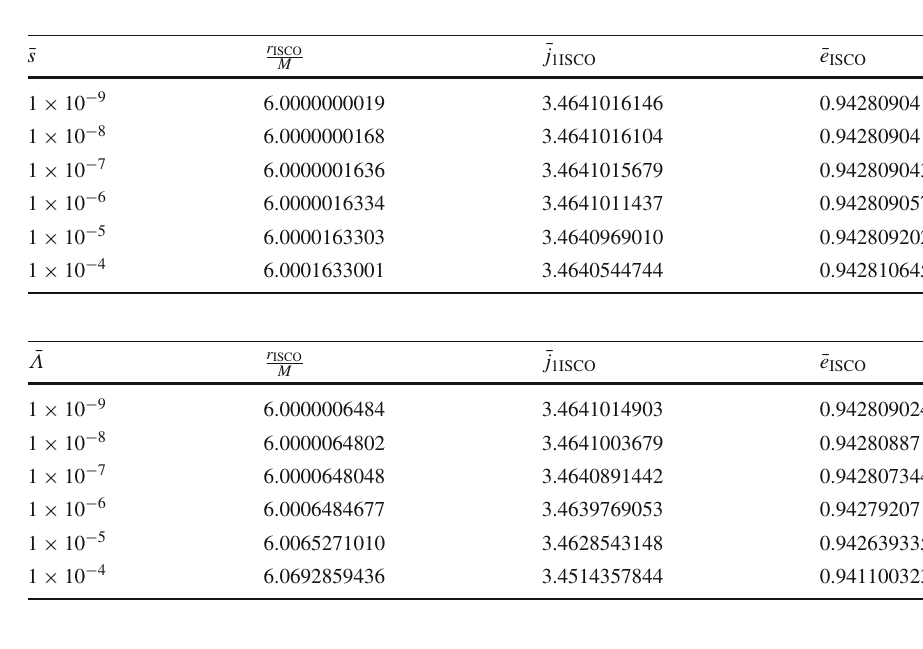
Fig. 1 Plots of the derivation of the ISCO parameters with different order of particle’s spin and cosmological constant. The orders of the particle’s spin and cosmological constant are set as 10 − 9 , 10 − 8 , 10 − 7 , 10 − 6 , 10 − 5 , and 10 −